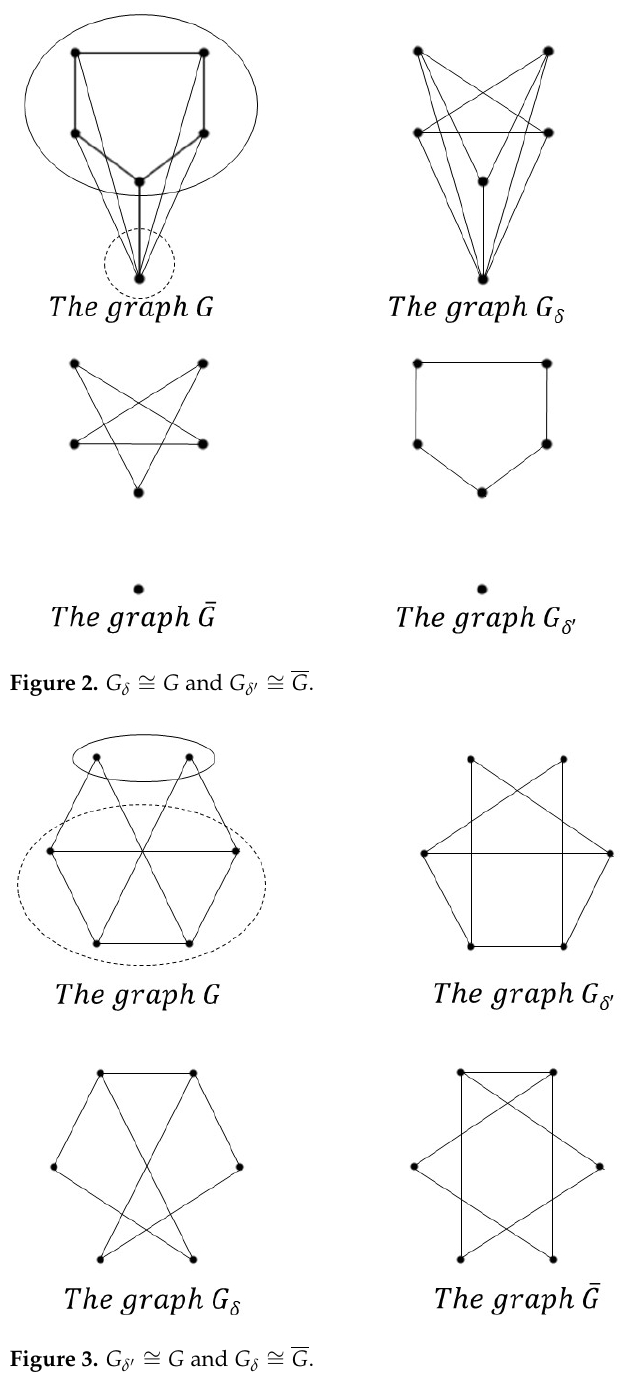
Figure 3. G δ (cid:48) ∼ = G and G δ ∼ = G